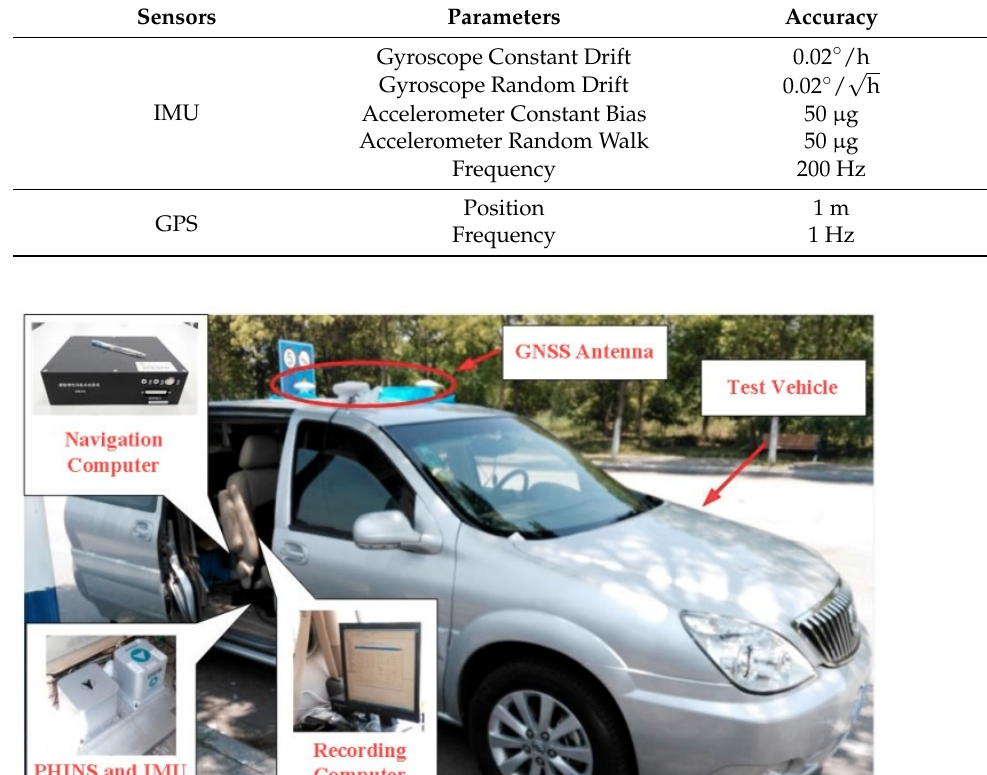
1 Hz Figure 3. Structure diagram of vehicle-mounted experiment. The whole experiment lasted approximately 5700 s; initial SINS alignment occurred during seconds 0–900, and SINS/GPS loosely integrated navigation occurred during